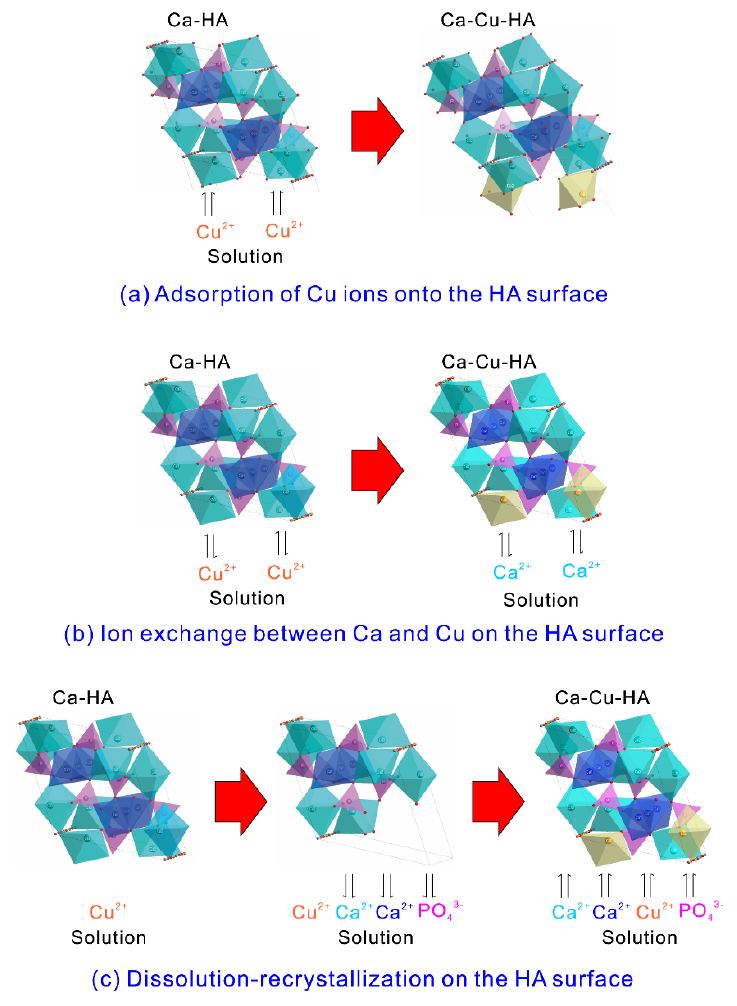
Figure 12. Cu (II)-removal mechanism by the SC–HA/C composite. ( a ) adsorption of Cu ions onto the HA surface; ( b ) ion exchange between Ca and Cu on the HA surface; ( c ) dissolution-recrystallization on the HA surface.